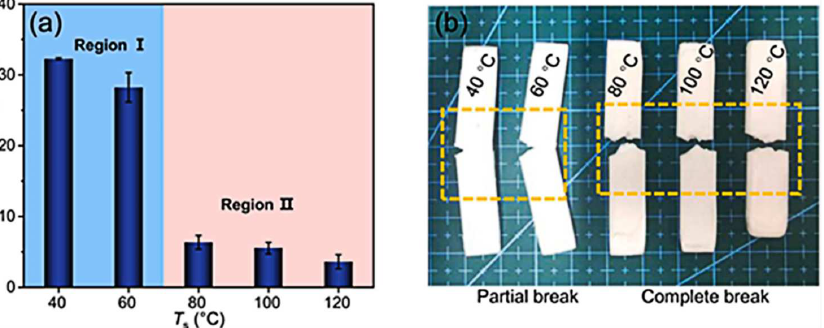
Figure 12. ( a ) Impact strength and ( b ) typical impact fracture photos of PLA foam samples with pressure-induced flow at different foaming temperatures (reproduced with permission from refer- ence [65], Copyright 2022 Elsevier).